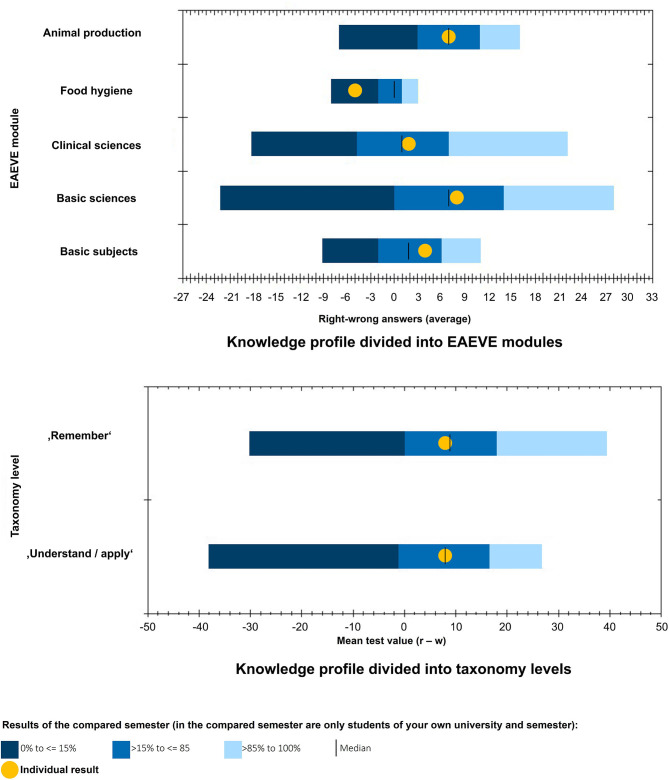
Knowledge profile divided into EAEVE (European Association of Establishments for Veterinary Education) modules and into taxonomy levels; exemplary presentation of a fifth-semester student; r, right answer; w, wrong answer.